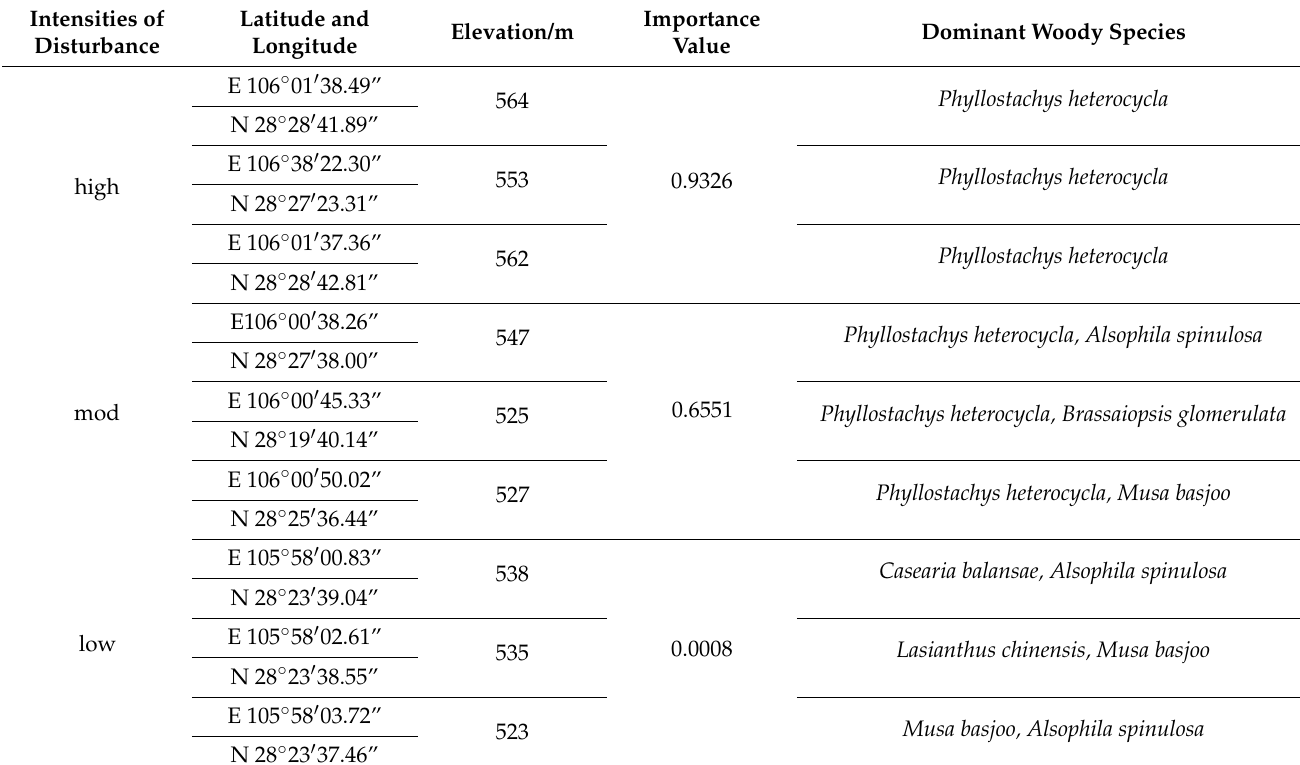
Table 1. The basic information about three sampling